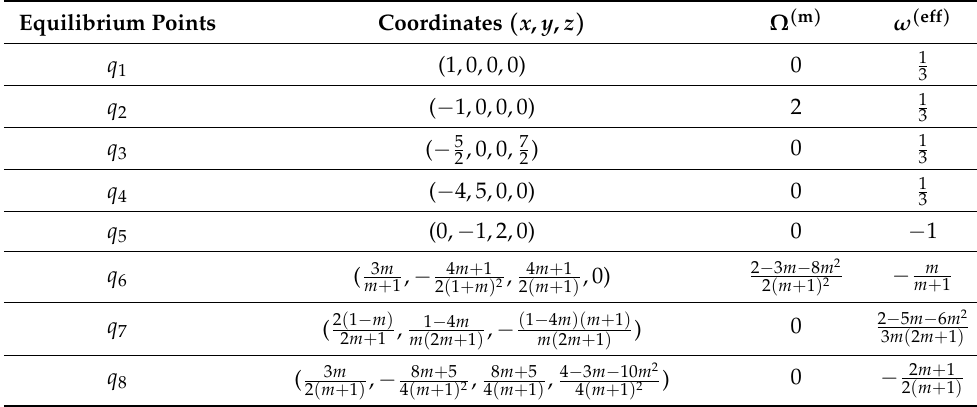
Table 5. Equilibrium points of system (44).